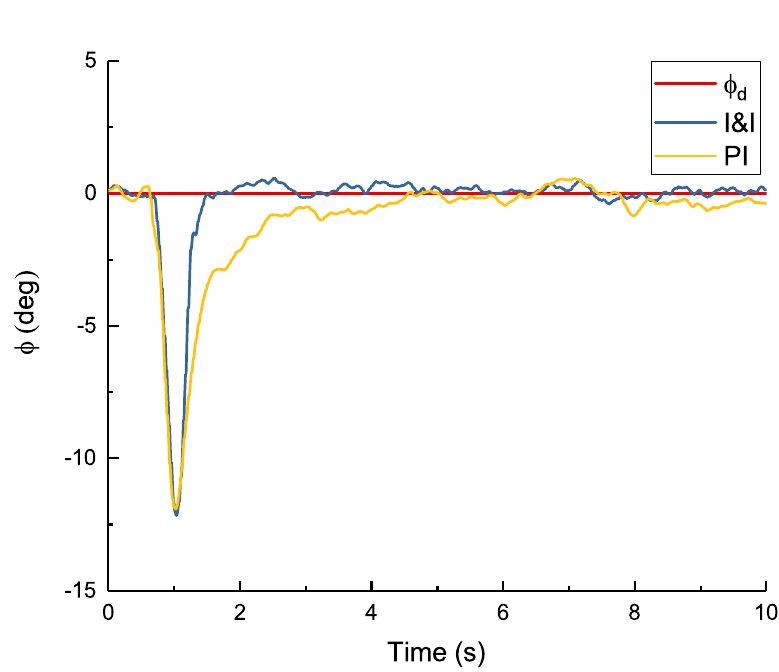
Figure 8. Roll Control Comparison between I&I and PI Control.